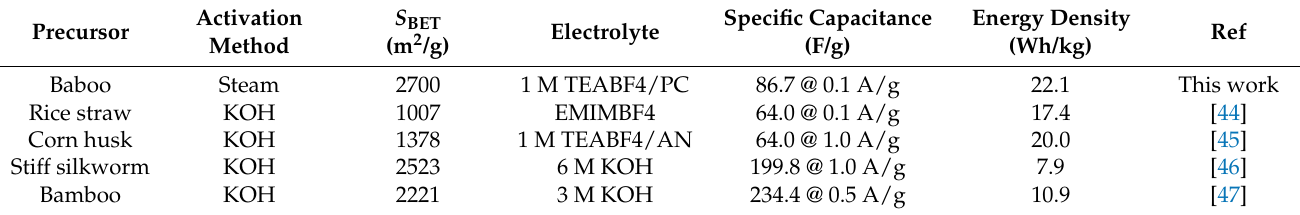
Figure 11. Ragone plot of the bamboo-derived activated carbon device compared with data in other literature studies. Table 3. The electrochemical performance comparison of various biomass-derived activated